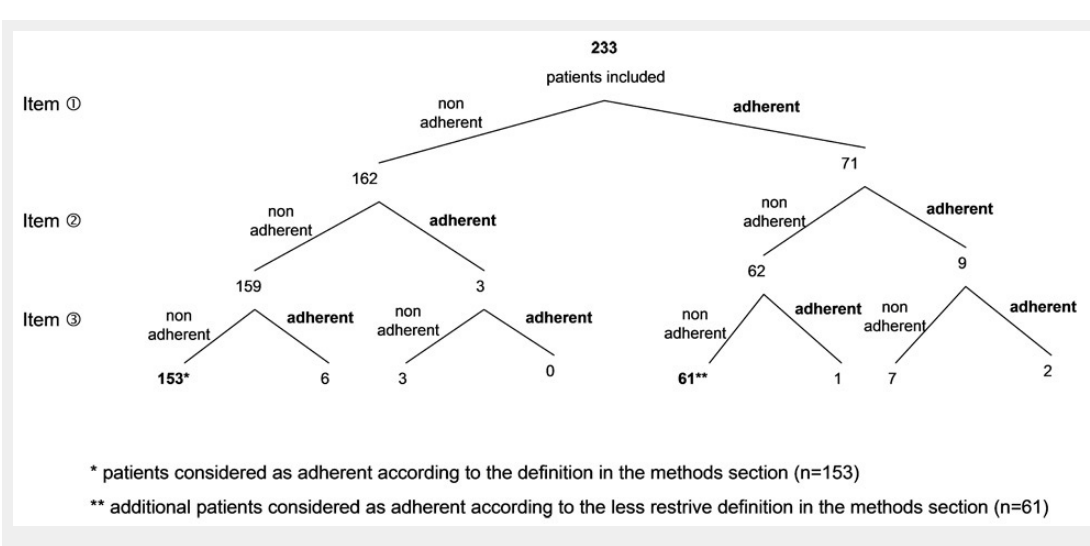
Figure 1 Responses given by the patients to the first three items of the